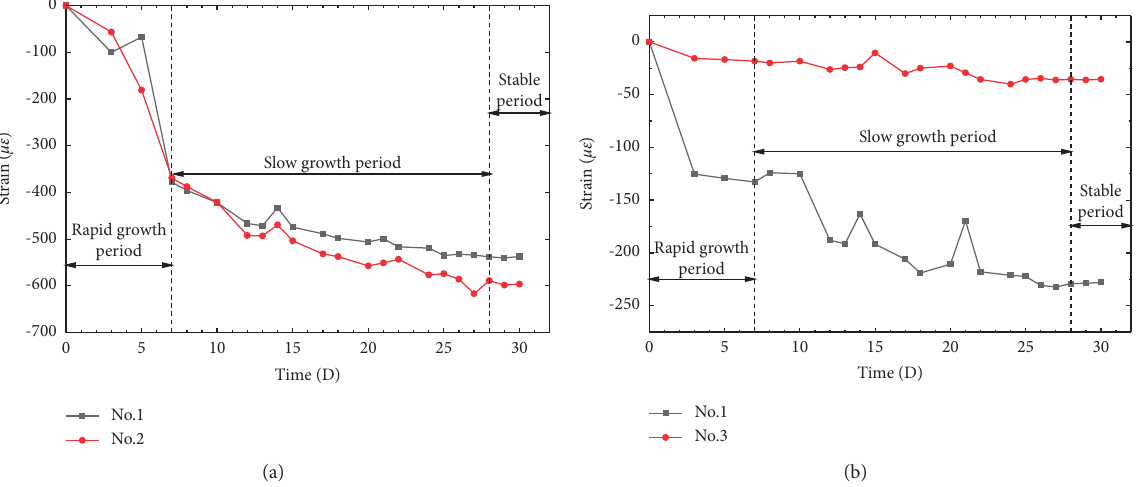
Figure 8: Strain variation of HPC at a depth of − 1117.7m. (a) Circumferential strain of HPC. (b) Axial strain of HPC.